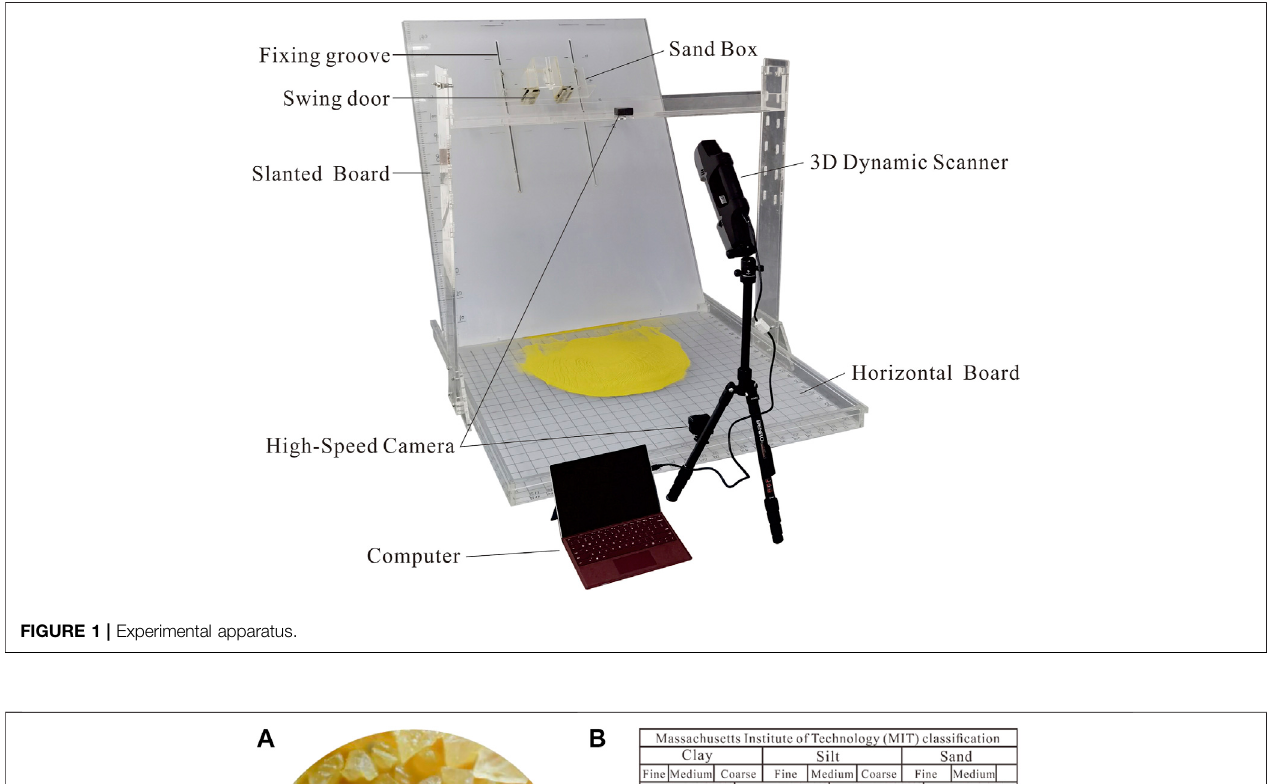
FIGURE 1 | Experimental apparatus.